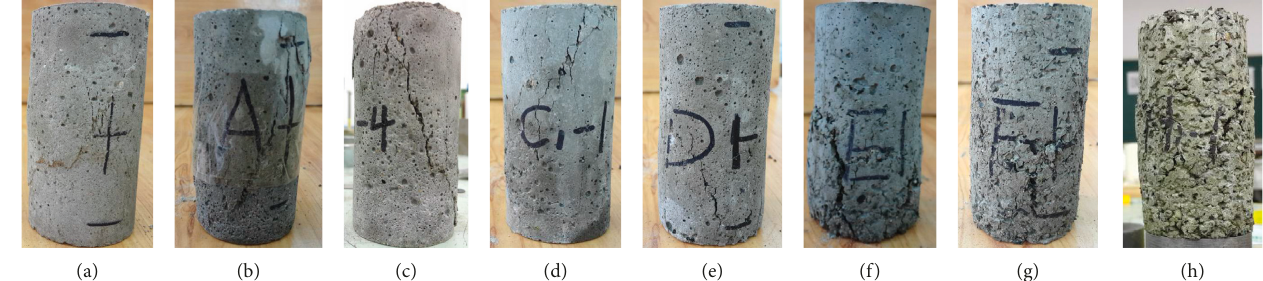
Figure 3: The shape of the destruction (from left to right: O, A, B, C, D, E, F, H).